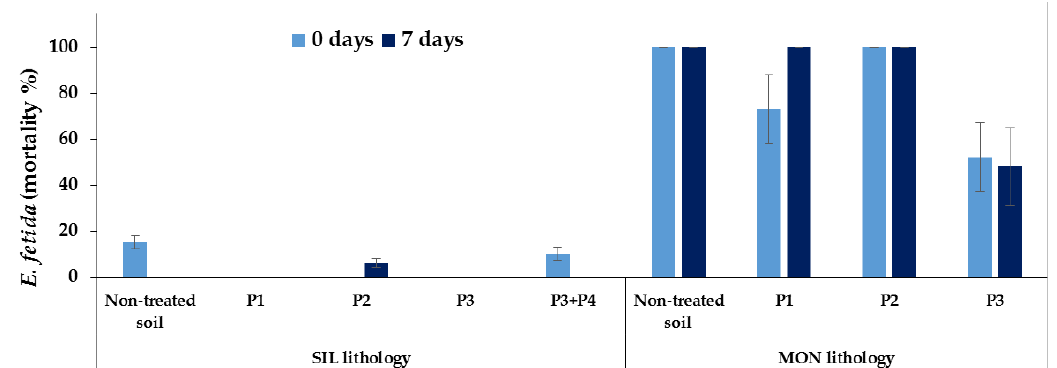
Figure 3. Chronic test (organism exposure period of 28 days) with the earthworm Eisenia fetida performed with soil samples at 0 and 7 days of the experiment. The results are expressed as mortality (%) SIL: sandy-silty-clay soil; MON: gravel in a sandy-silty soil. P1, P2, P3, P4: foaming agent products. The vertical bars represent the standard errors.